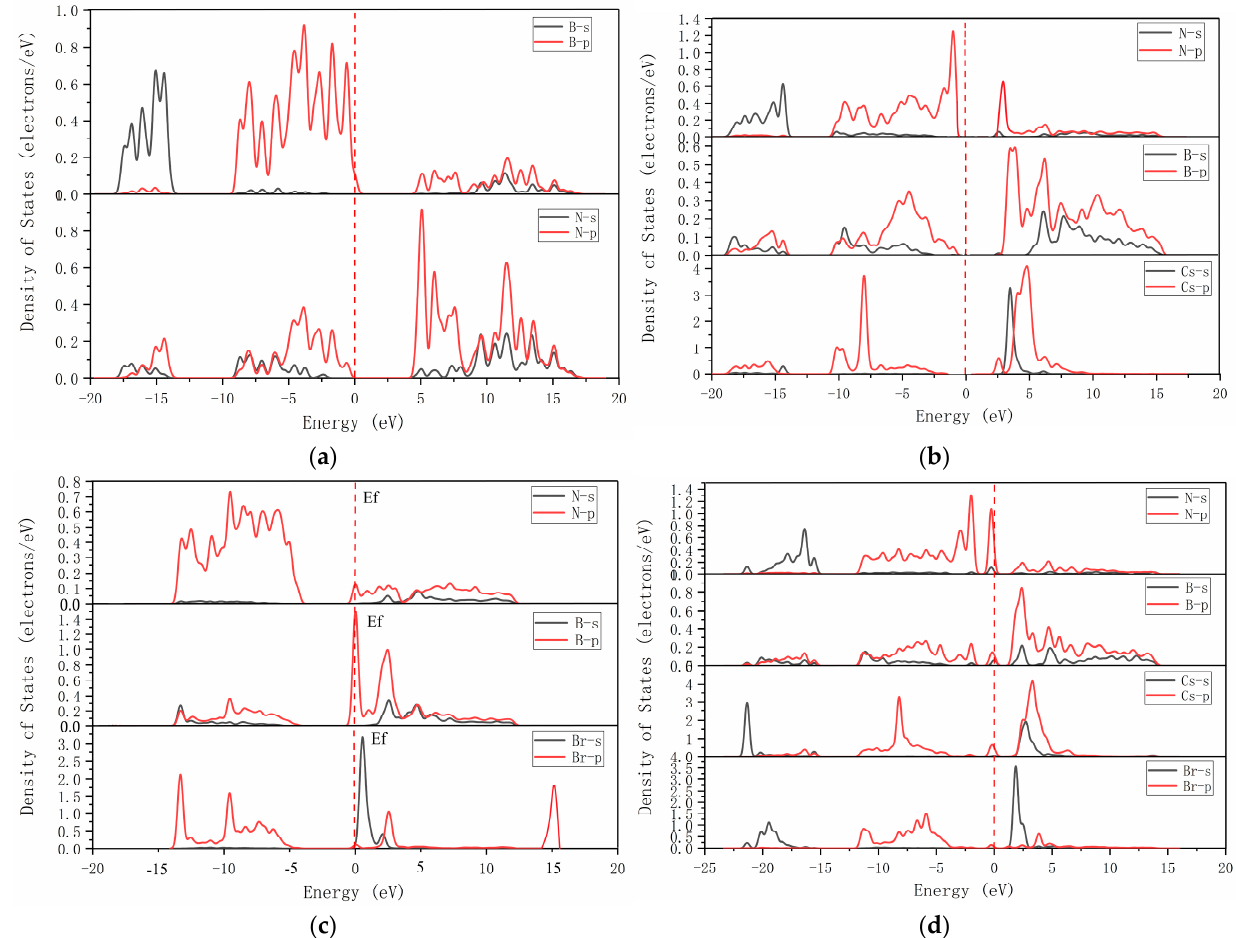
Figure 6. PDOS for intrinsic and doped boron nitride: ( a ) intrinsic, ( b ) Cs − doped, ( c ) Br − doped and ( d ) Cs − Br co − doped h-BN.